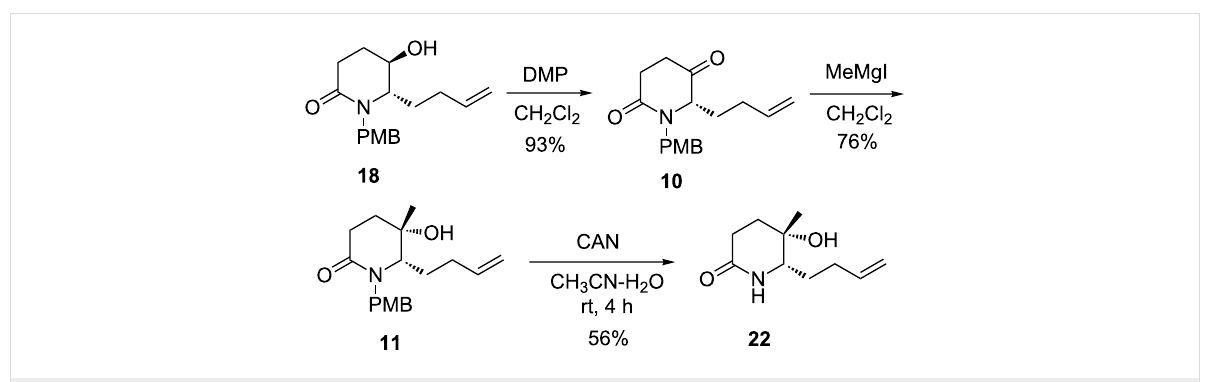
Scheme 8: Synthesis of tertiary alcohol 22 .